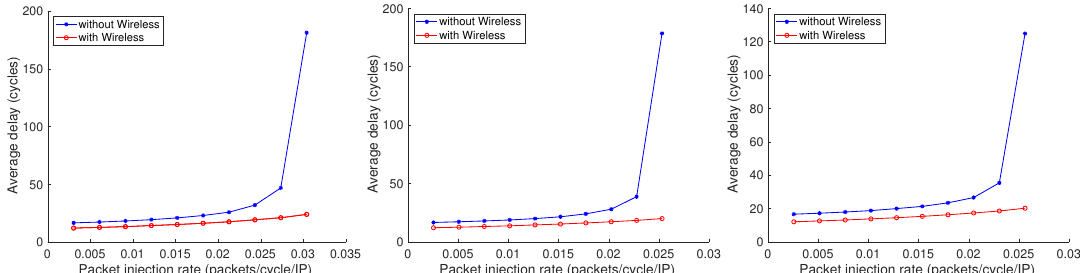
Figure 7. From left to right: Average delay for profiles T 4 , T 8 , and T 16 for 64 Delta MIN topology and table-based traffic (TT-64 Delta MIN).